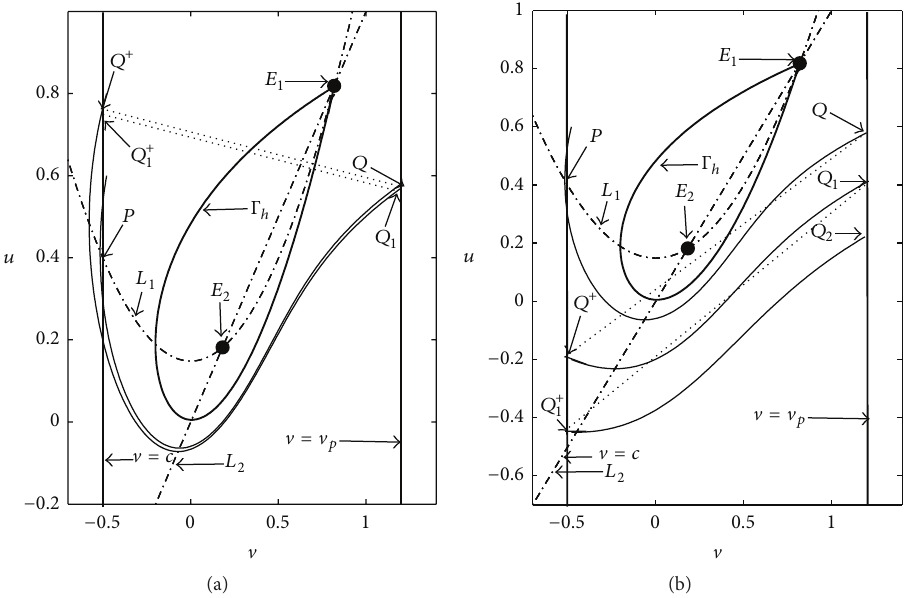
Figure 3: Location of the periodic solution of system (2) for case (𝐴 1 ) when 𝑐 < V 4 or 𝑐 > V 1 . (a) The case when the pulsed point 𝑄 + is above the point 𝑃 ; (b) the case when the pulsed point 𝑄 + lies below the point 𝑃